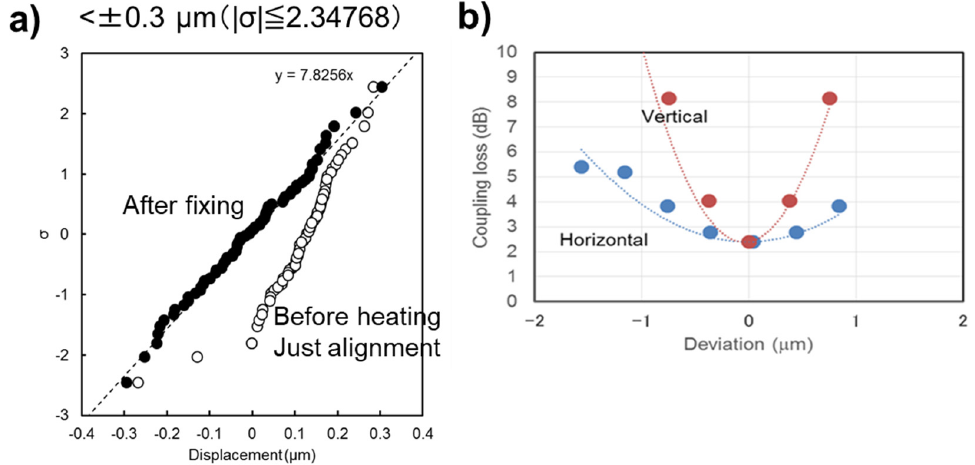
Figure 10. Laser mounting accuracy and coupling loss. ( a ) Distribution of mounting accuracy; ( b ) coupling loss variation with horizontal and vertical